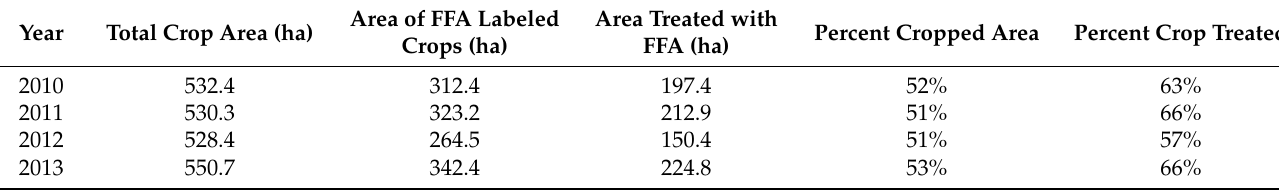
Table 2. Annual cropped and treated areas at GKb. Percent cropped area is calculated as FFA labeled crop area divided by watershed area (1030 ha) and percent crop treated is calculated as the area treated with FFA divided by the area of FFA labeled